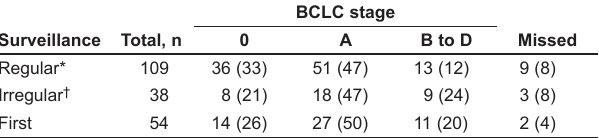
TABlE 3 Comparison of surveillance interval and tumour stage determined using the Barcelona Clinic liver